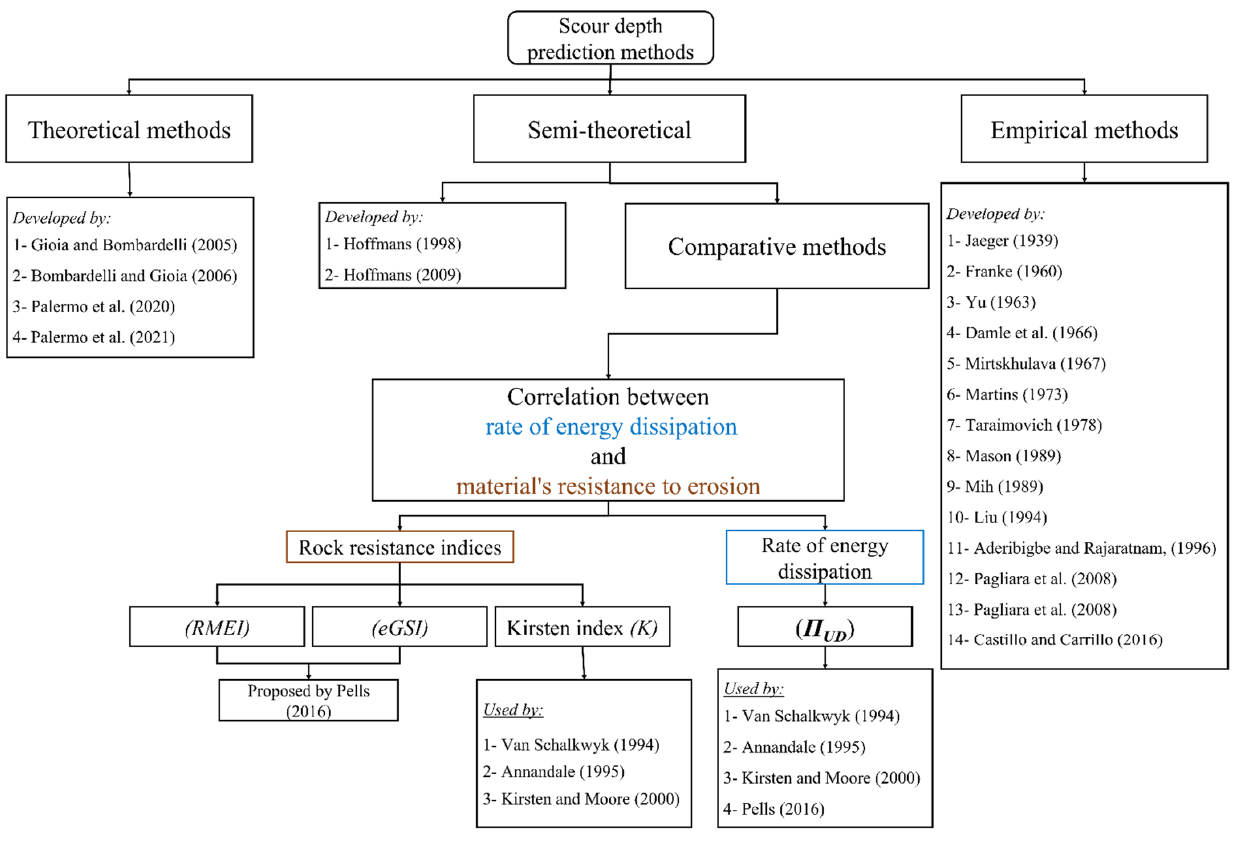
Figure 2. Classifications of the scour prediction methods .